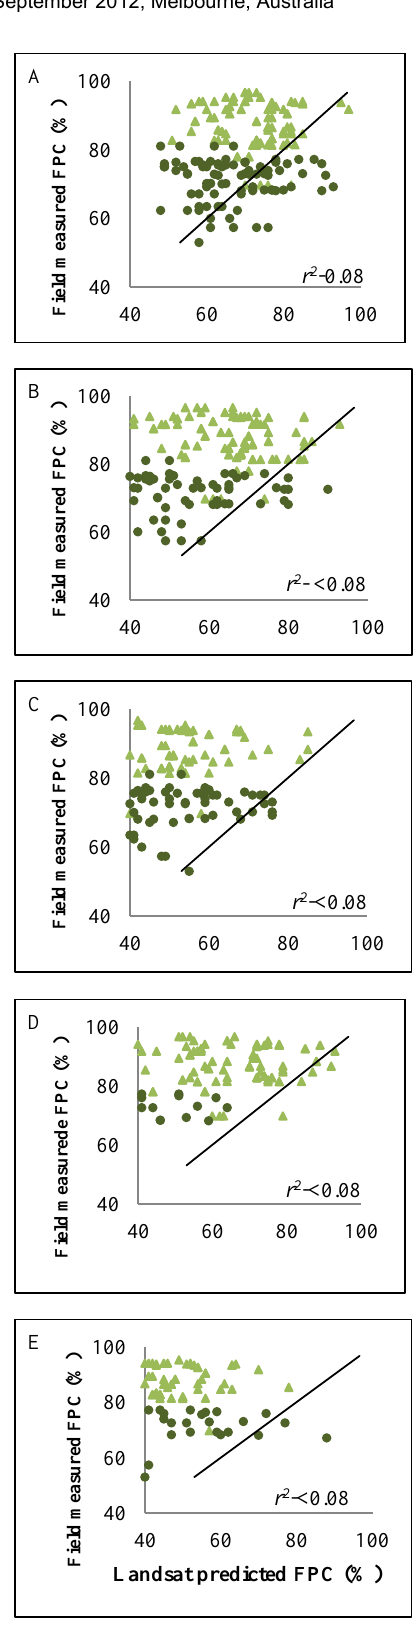
Figure 5. The relationship between field estimated overstorey FPC and low sun angle TM5 predicted overstorey FPC: A- PSSSR, B- SCS+C correction, C- C correction, D- Minnaert correction and E- SCS correction. Symbols denote study area in BRNP (triangles) and RRNP